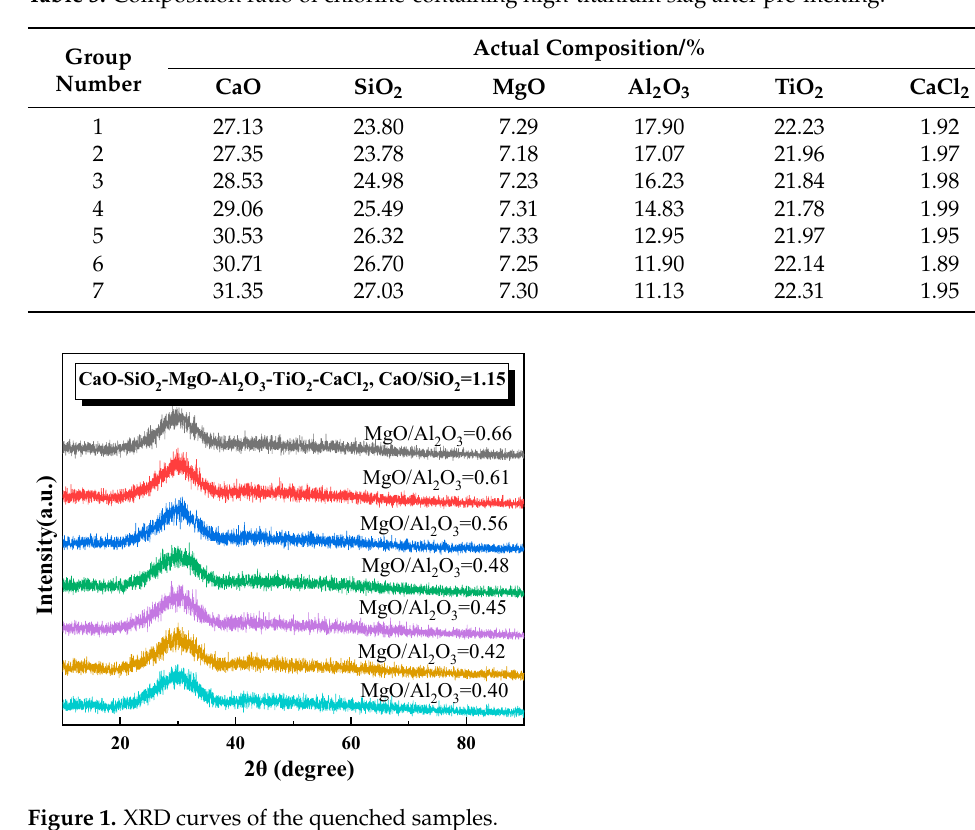
Table 3. Composition ratio of chlorine-containing high-titanium slag after pre-melting.